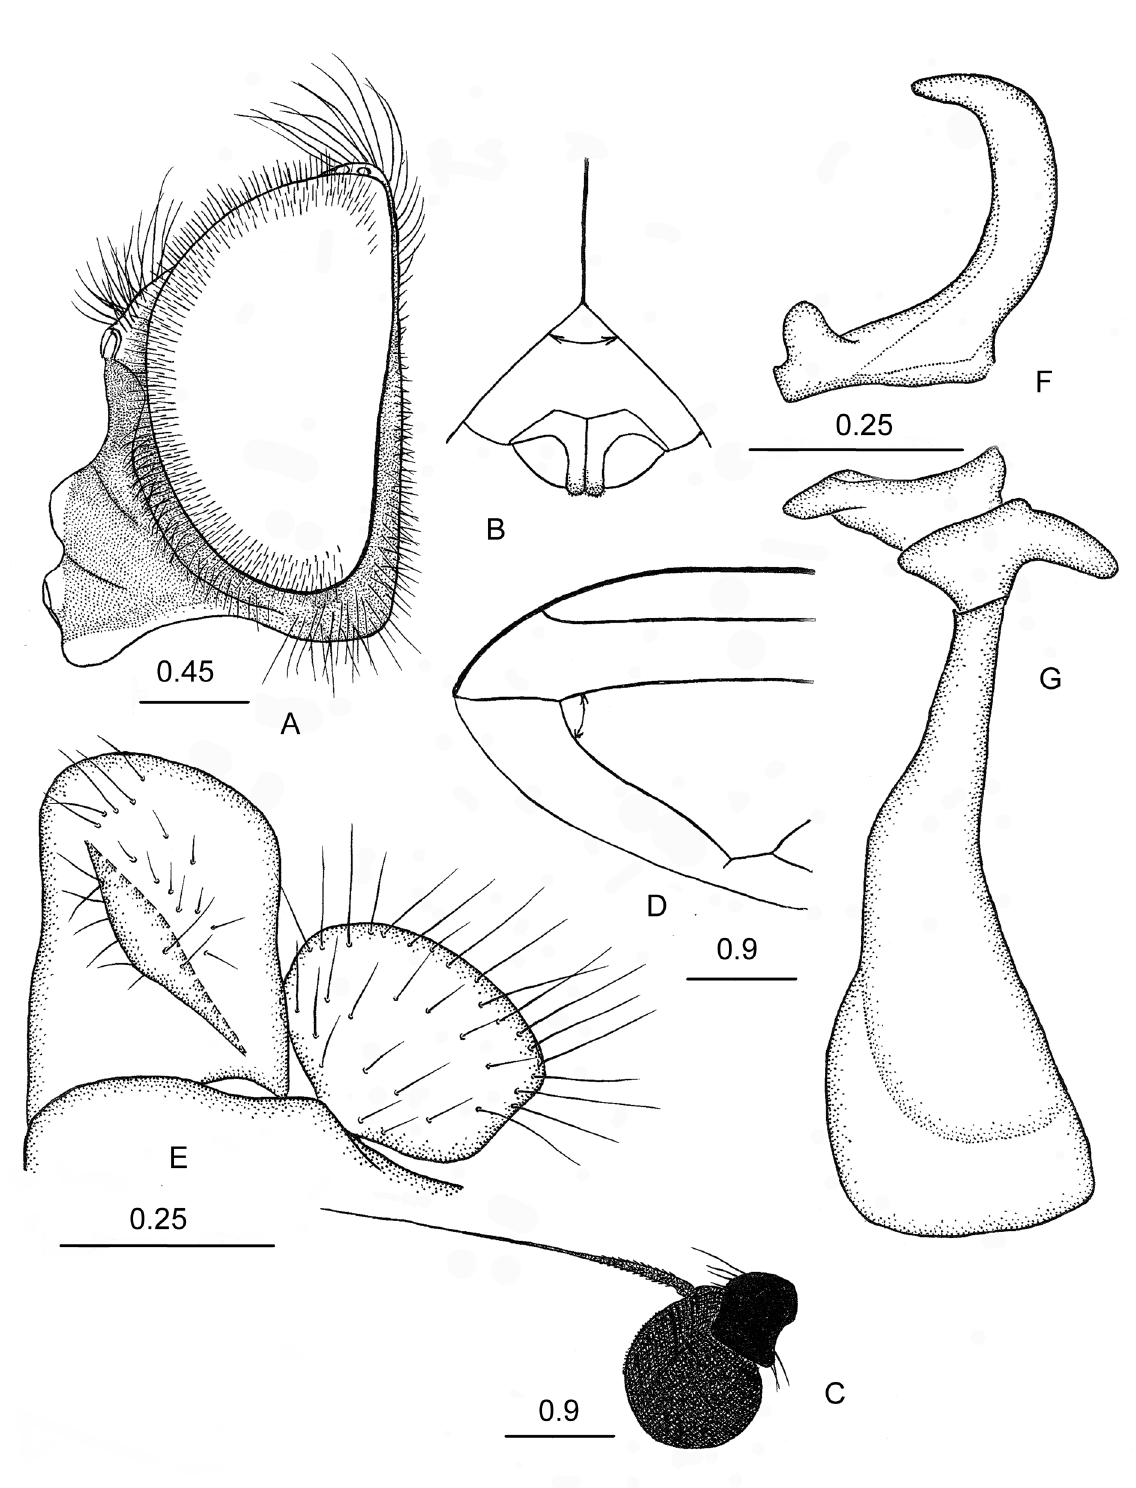
Fig. 20. Cheilosia ( Cheilosia ) falcata sp. nov., holotype, ♂ (SMNS). A . Head, lateral view. B . Angle approximation of eyes (indicated by bent arrow). C . Antenna, lateral view of pedicel and basoflagellomere. D . Tip of wing. E . Surstylus and gonocercus, lateral view. F . Superior lobe of hypandrium, lateral view. G . Aedeagus and aedeagal apodeme, lateral view. Scale bars indicated in